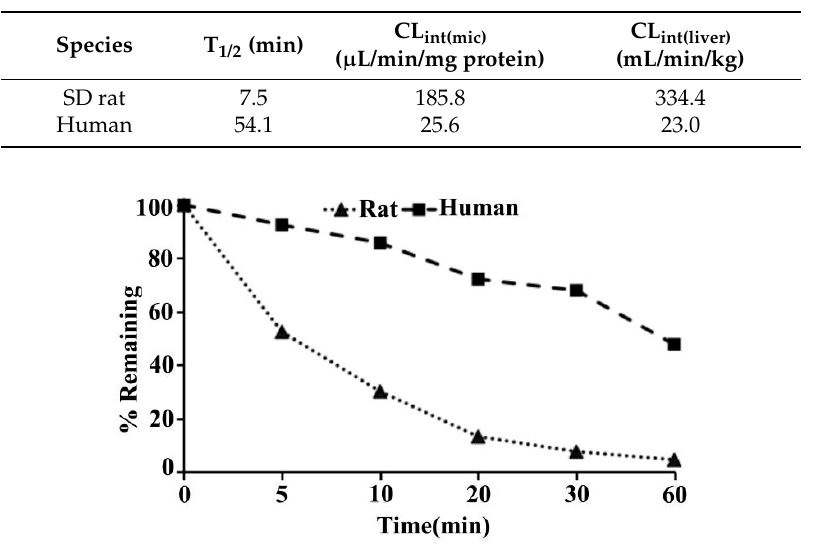
Figure 13. Percentage remaining versus time profile of ADC in SD rat and human liver microsomes. Table 1. Metabolic stability of ADC in SD rat and human liver microsomes following incubation in the presence of NADPH .